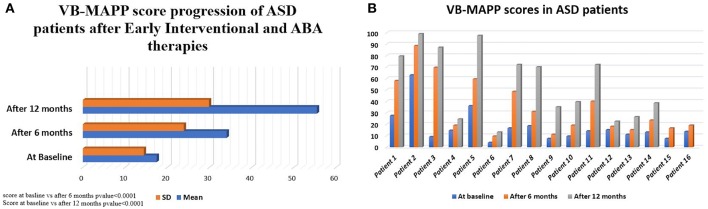
(A) VB-MAPP median scores of 16 ASD patients at diagnosis, 14 ASD patients after 6 and 12 months of interventional therapies. The score increased from a median of 13.75 [4-63.59] at diagnosis to reach 21.25 [10-88.78] and 70 [13-99.86] at 6 and 12 months, respectively. Wilcoxon Signed Ranks test was done to detect differences between the 3 scores at diagnosis and at 6 months (p < 0.0001), score at 6 months and 12 months (p < 0.0001). (B) Progression of VB-MAPP scores and improvement of values at diagnosis and over 12 months of therapy in ASD patients (14/16 cases with assessments at diagnosis, 6 and 12 months after therapy, 2/16 cases with first and second assessment at diagnosis and at 6 months).